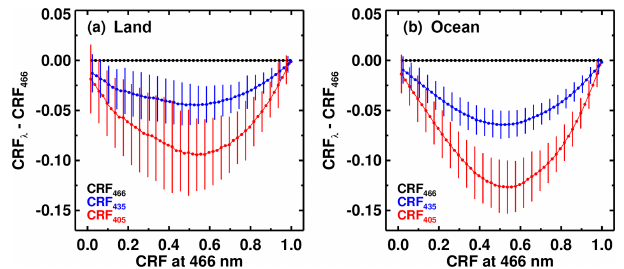
Figure 17. Similar to Fig. 16 but for